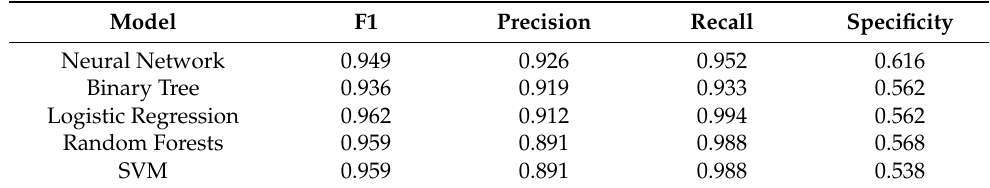
Table 17. Models accuracy metrics for add to cart action (class 1) with add_to_cart_indirect as target parameter.